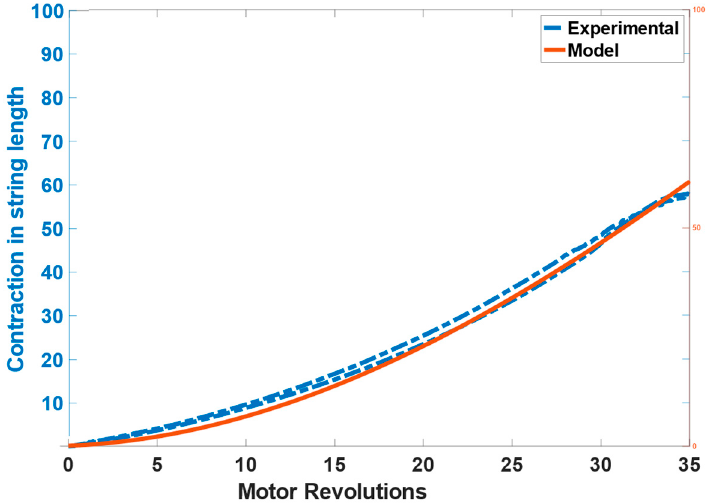
Figure 6. Actuator model validation results showing the contraction in string’s length.